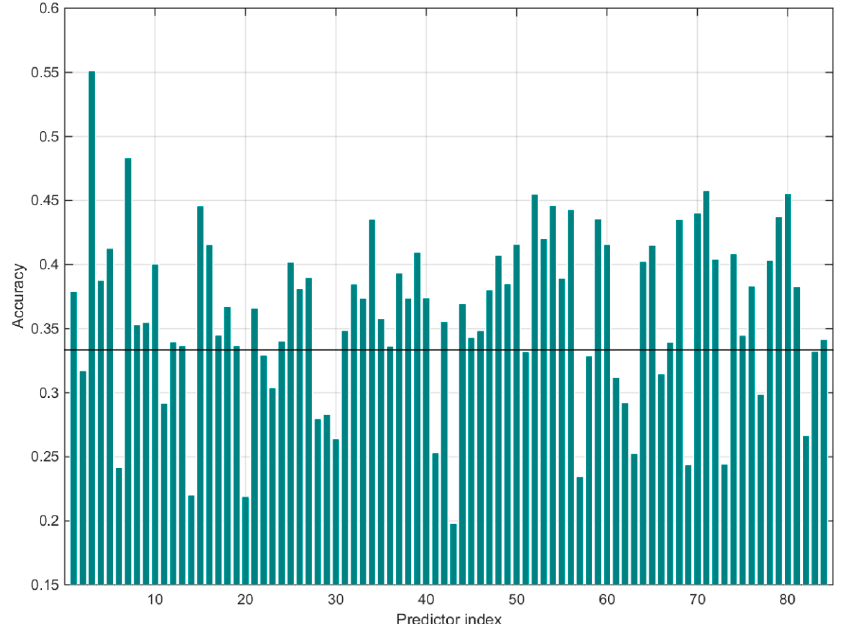
Figure 3. The repeated 10-fold cross-validation (CV) score of the multinomial logistic regression (MLR) model using one individual predictor. The black line indicates the baseline of the classification accuracy of 0.33. The names of predictors corresponding to the indices are listed in the Appendix.